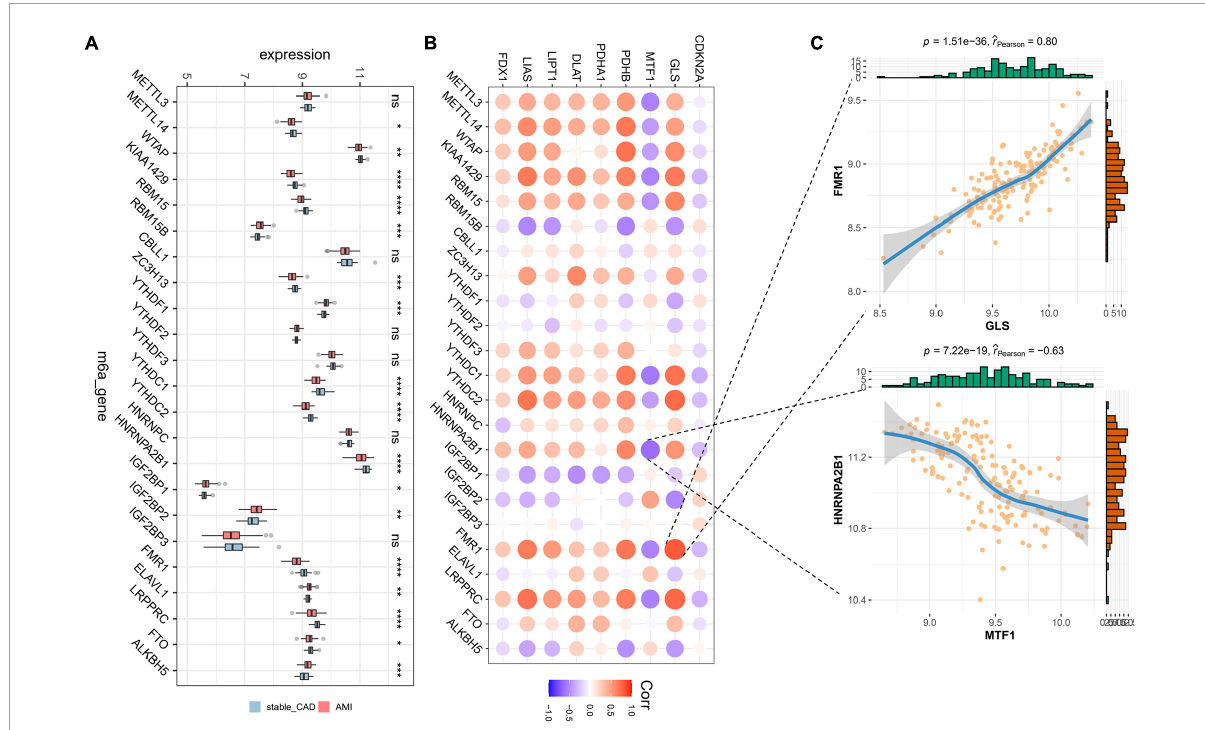
FIGURE3 Landscape of m6A-related genes and the correlation degree between cuproptosis-related genes (CRGs) and m6A-related genes. (A) The boxplot of differential expression of m6A-related genes in AMI (stable_CAD, stable coronary heart disease; AMI, acute myocardial infarction). (B) The heatmap of the correlation degree between CRGs and m6A-related genes (the darker the color and the larger the graph, the more relevant it is. Red is positive, and purple is negative). (C) Correlation between GLS and FMR1 as well as MTF1 and HNRNPA2B1. * P < 0.05, ** P < 0.01, *** P < 0.001, **** P <